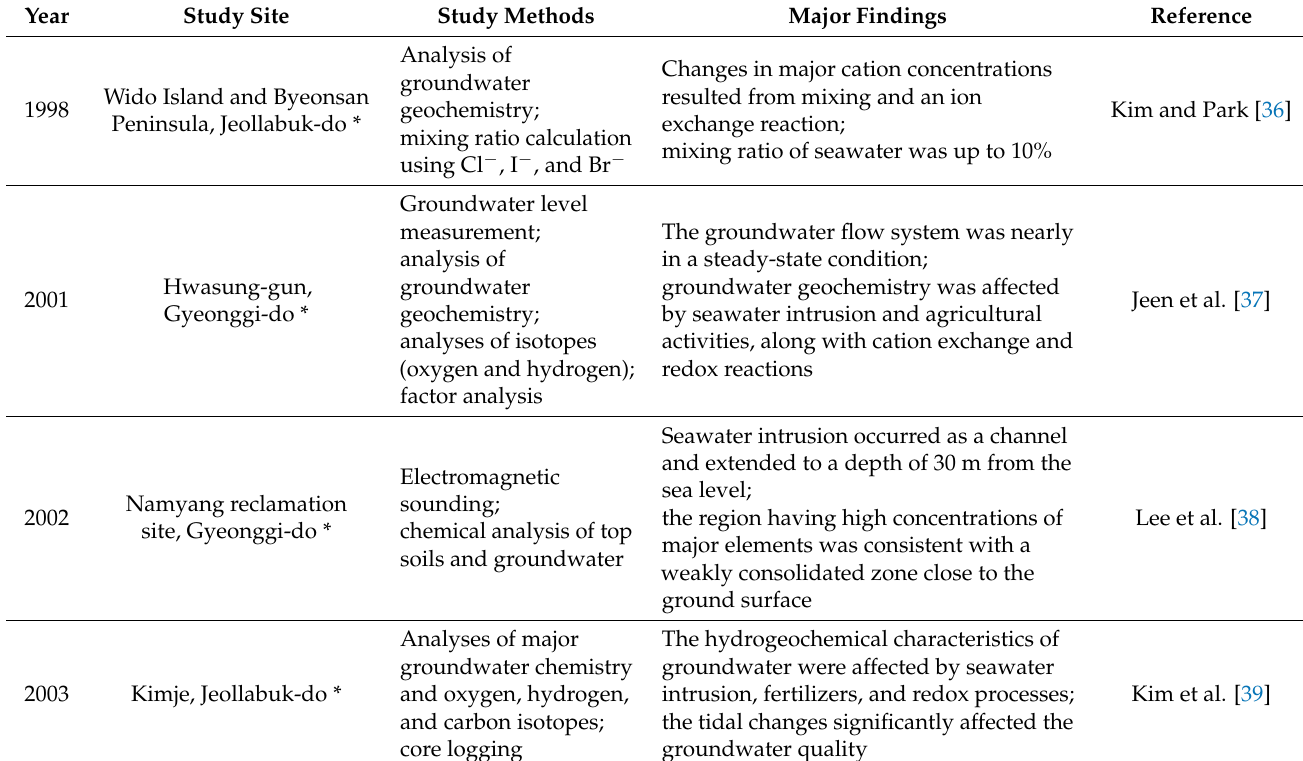
Table 1. Summary of studies on seawater intrusion in South Korea published in international